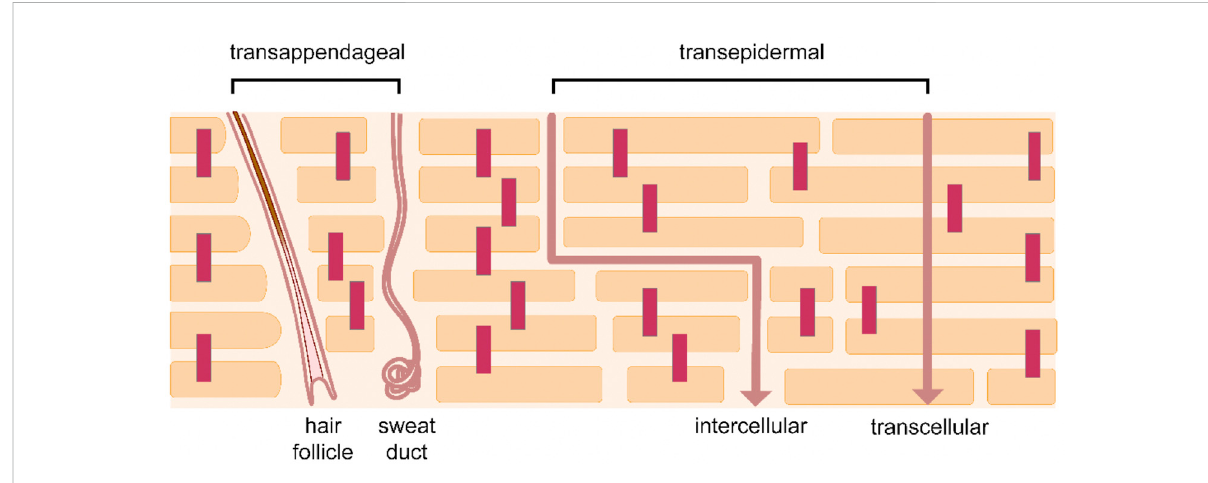
FIGURE 1 Skin permeation pathways. Reprinted from Rahma and Lane (2022), according to the terms and conditions of the Creative Commons Attribution 4.0 International License (CC BY